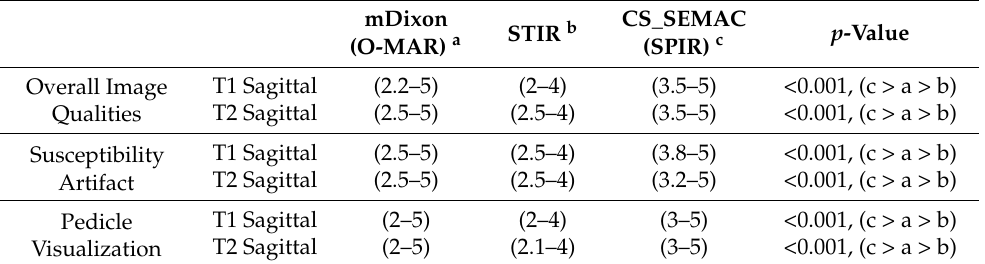
Table 6. Result of qualitative analysis of T1, T2 MAR effect when tested with Pig L-spine Phantom (Median).